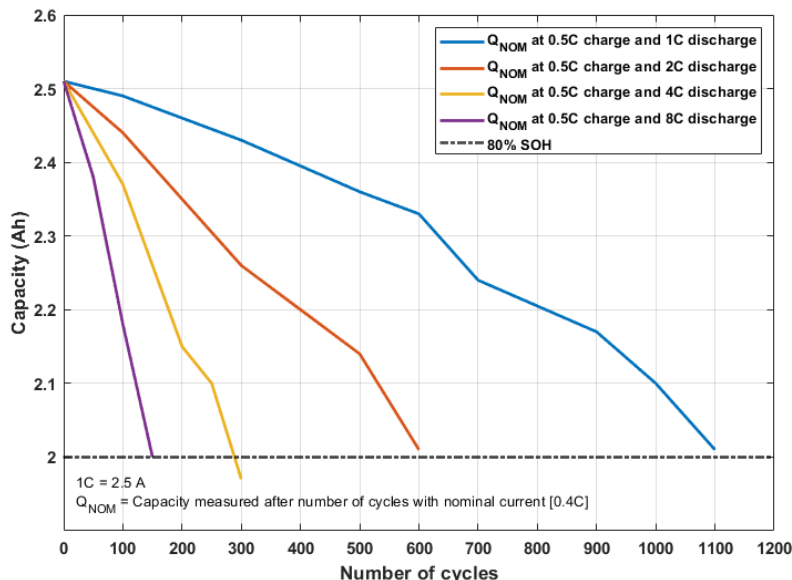
Figure 16. Influence of the number of cycles and discharging current on capacity